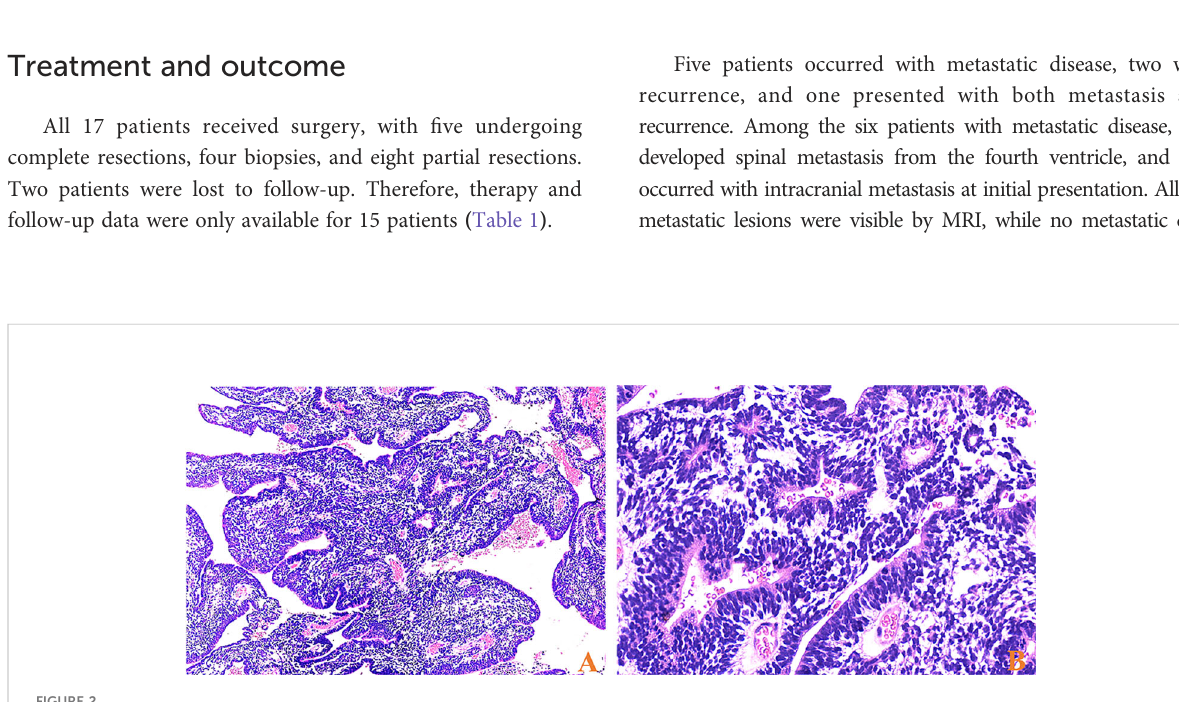
FIGURE 2 HE stainings of medulloepithelium for case 9, (A) papillary-like and tubular structures resembling the primitive neural tube (×40) and (B) on the luminal surface of these tubules, cilia, and blepharoplasts were absent